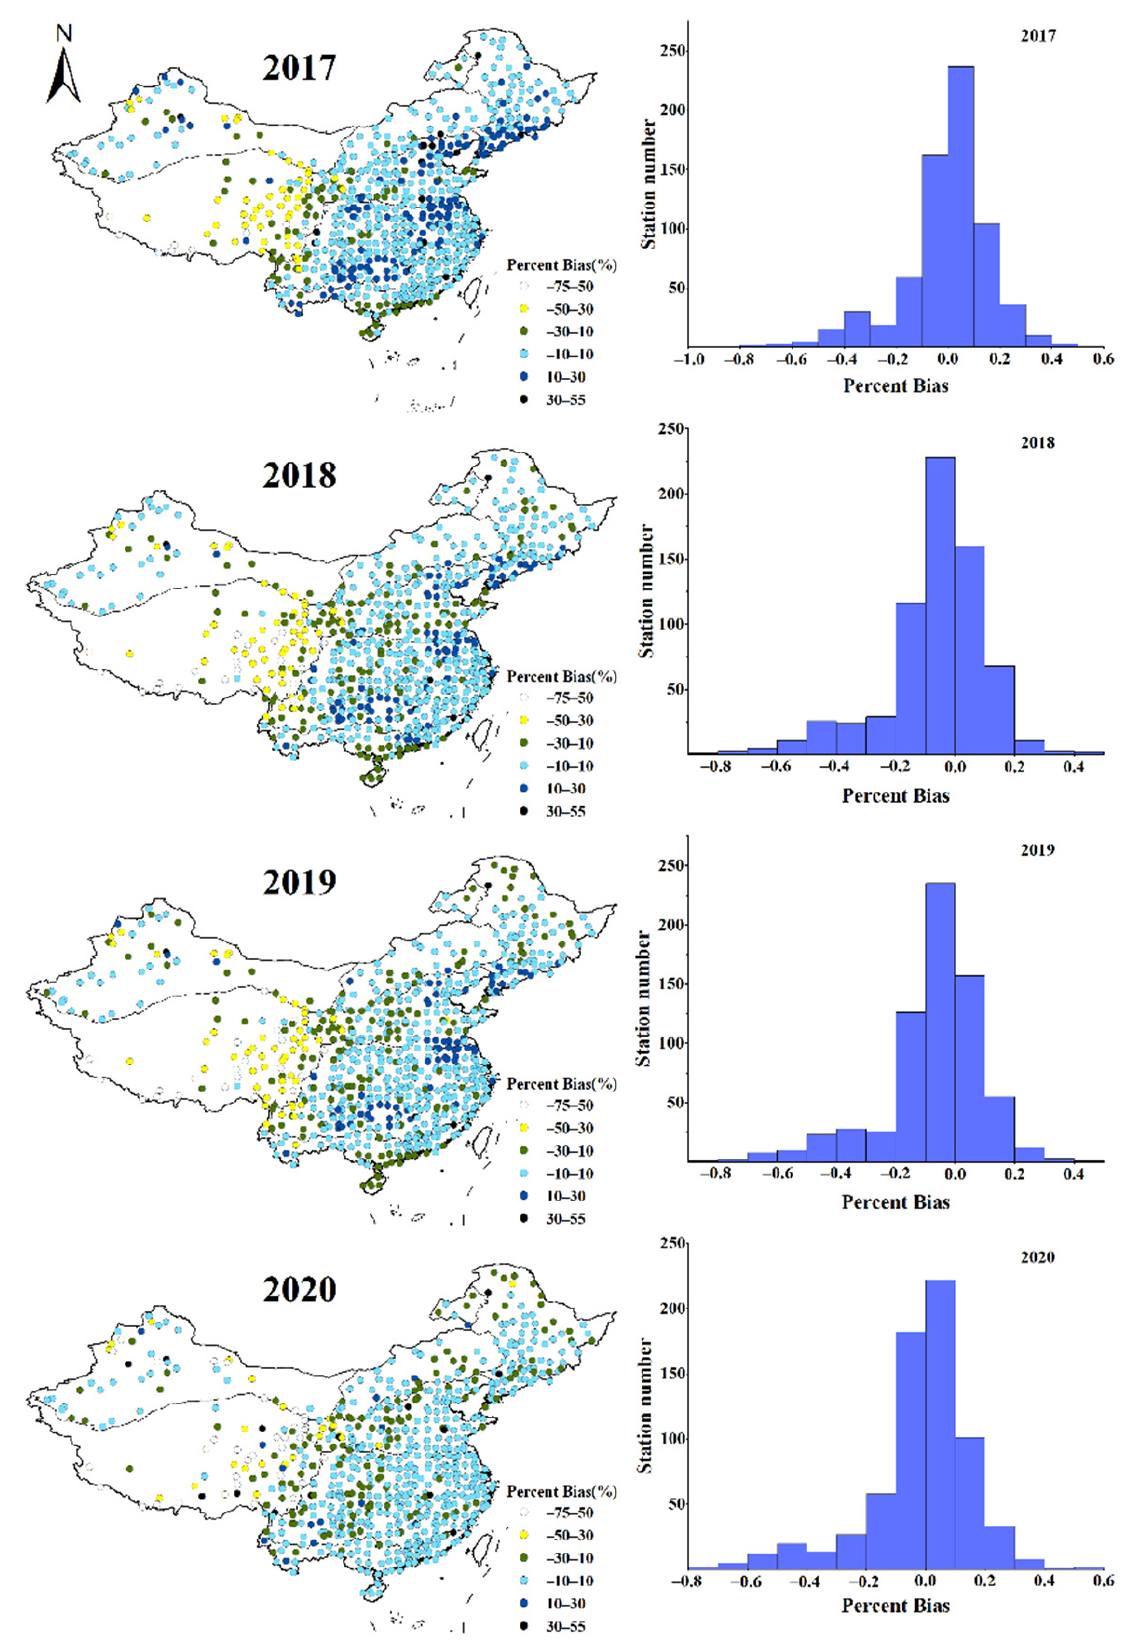
Figure 12. ET 0 annual PBias distribution calculated from CLDAS dataset